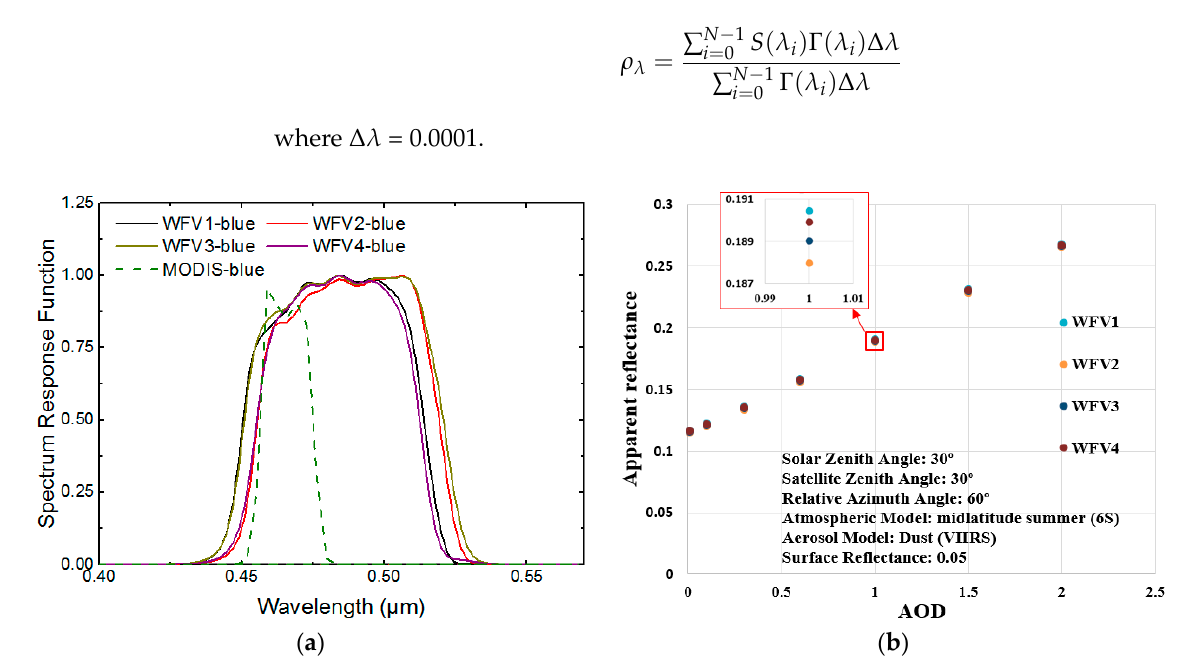
Figure 5. ( a ) The spectrum response function (SRF) of WFV and MODIS blue bands. The dash line is the SRF of MODIS bands 3 (0.466 µ m), and the solid lines are for WFV1-WFV4 band 1 (0.484 µ m). All the spectrum response functions use the same wavelength interval (0.0001 µ m) by interpolation. ( b ) The change of simulated apparent reflectance in blue band with different AOD and WFVs.